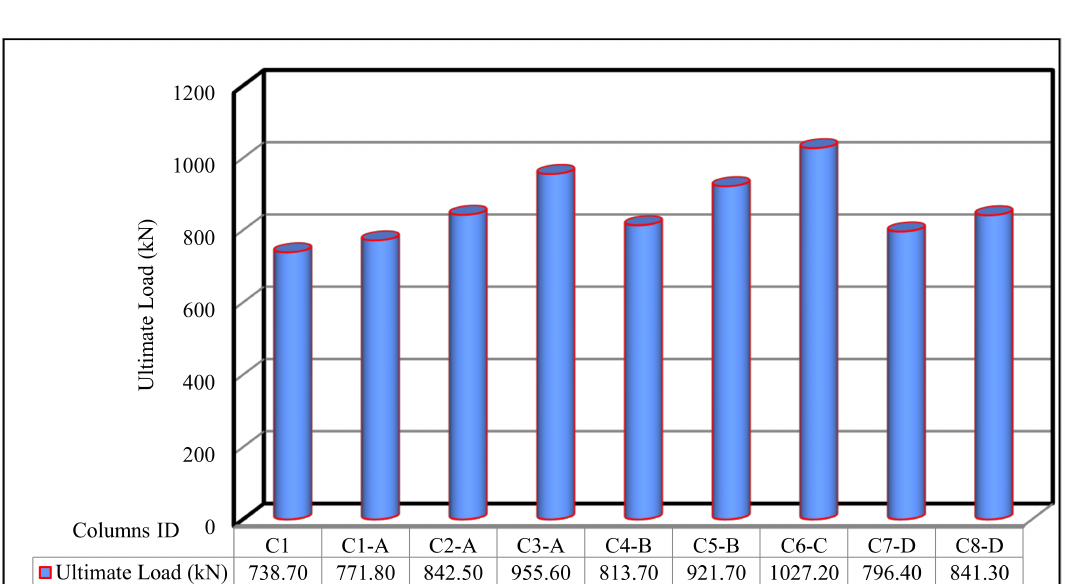
Figure 10. Serviceability load for the tested columns.